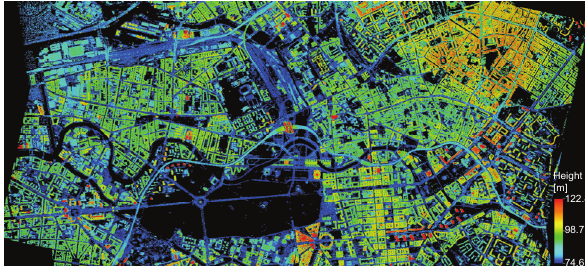
Figure 2. The fused TomoSAR point cloud of Berlin, which combines the result from an ascending stack and a descending stack. The height is